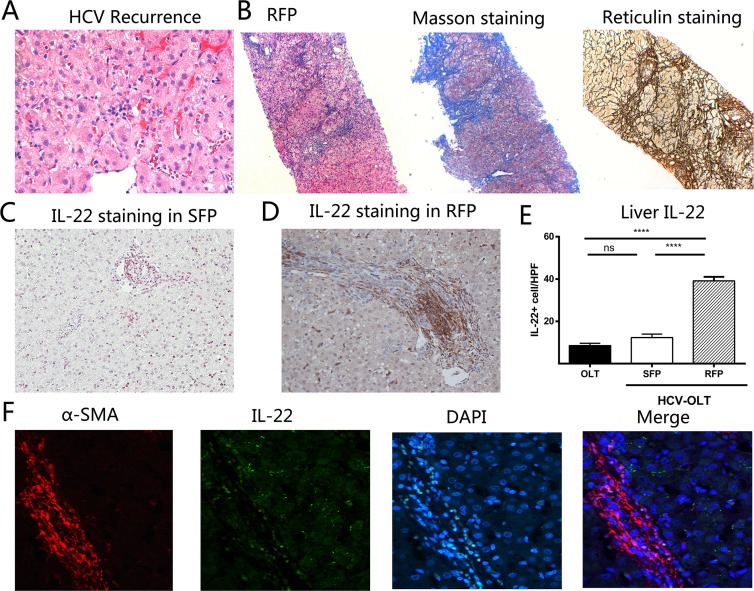
Frequencies of IL-22 cells are associated with liver fibrosis in the HCV-OLT patients.(A) Liver histology shows no fibrosis in the livers of patients when HCV recurred. (B) However, after two years, HE, Masson trichrome and reticulin staining illustrate significantly the progressive worsening of liver fibrosis in RFP. Compared with SFP (C), more IL-22 cells were infiltrated in RFP, mainly located in the portal (D). (E) IL-22 frequencies in liver significantly elevated in RFP compared with SFP. No significant difference between OLT and SFP groups. (F) The co-expression of IL-22R and α-SMA was observed in the liver tissues of RFP by immunofluorescence. *P < 0.05, **P < 0.01, ***P < 0.001, **** P < 0.0001, ns p>0.05.